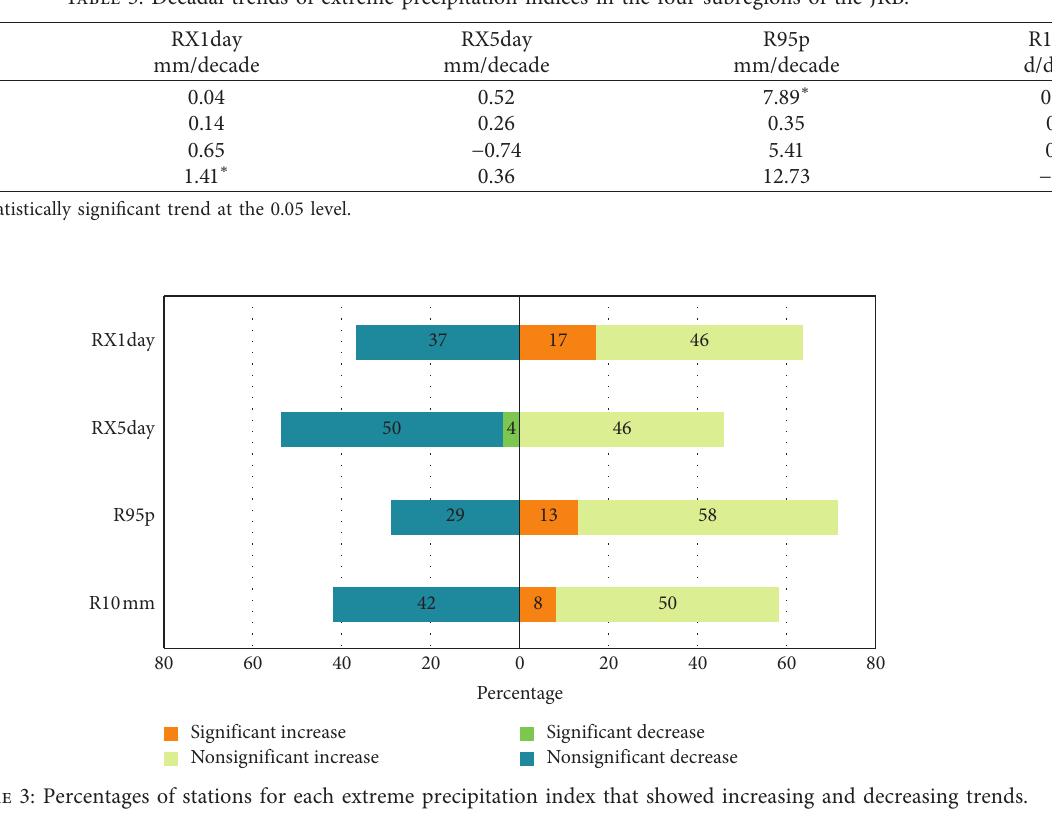
Table 5: Decadal trends of extreme precipitation indices in the four subregions of the JRB.